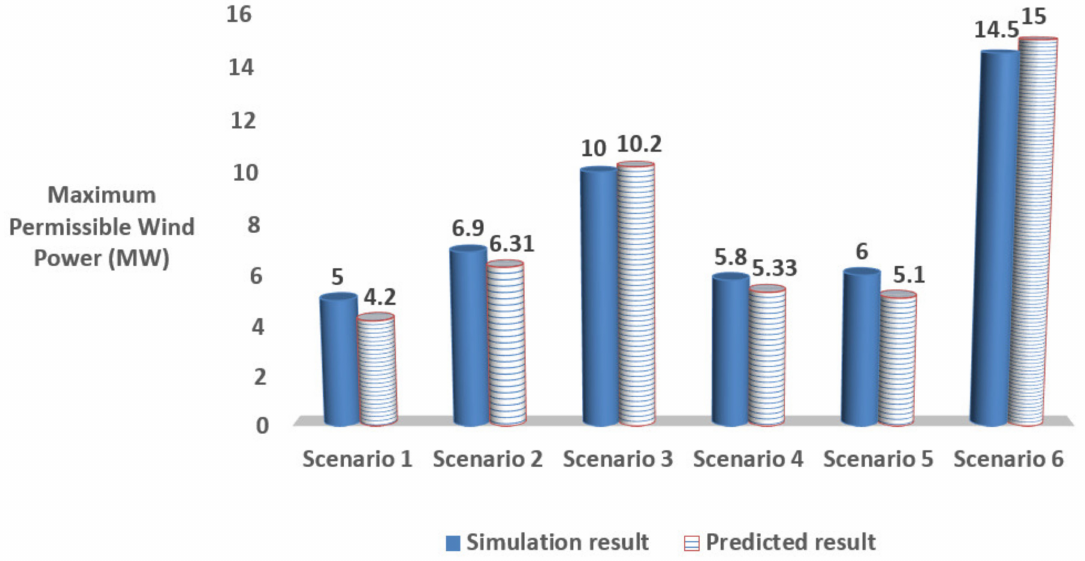
Figure 8. Maximum permissible wind power generation ensuring 0.95 < V PCC < 1.05 for Scenarios 1 to